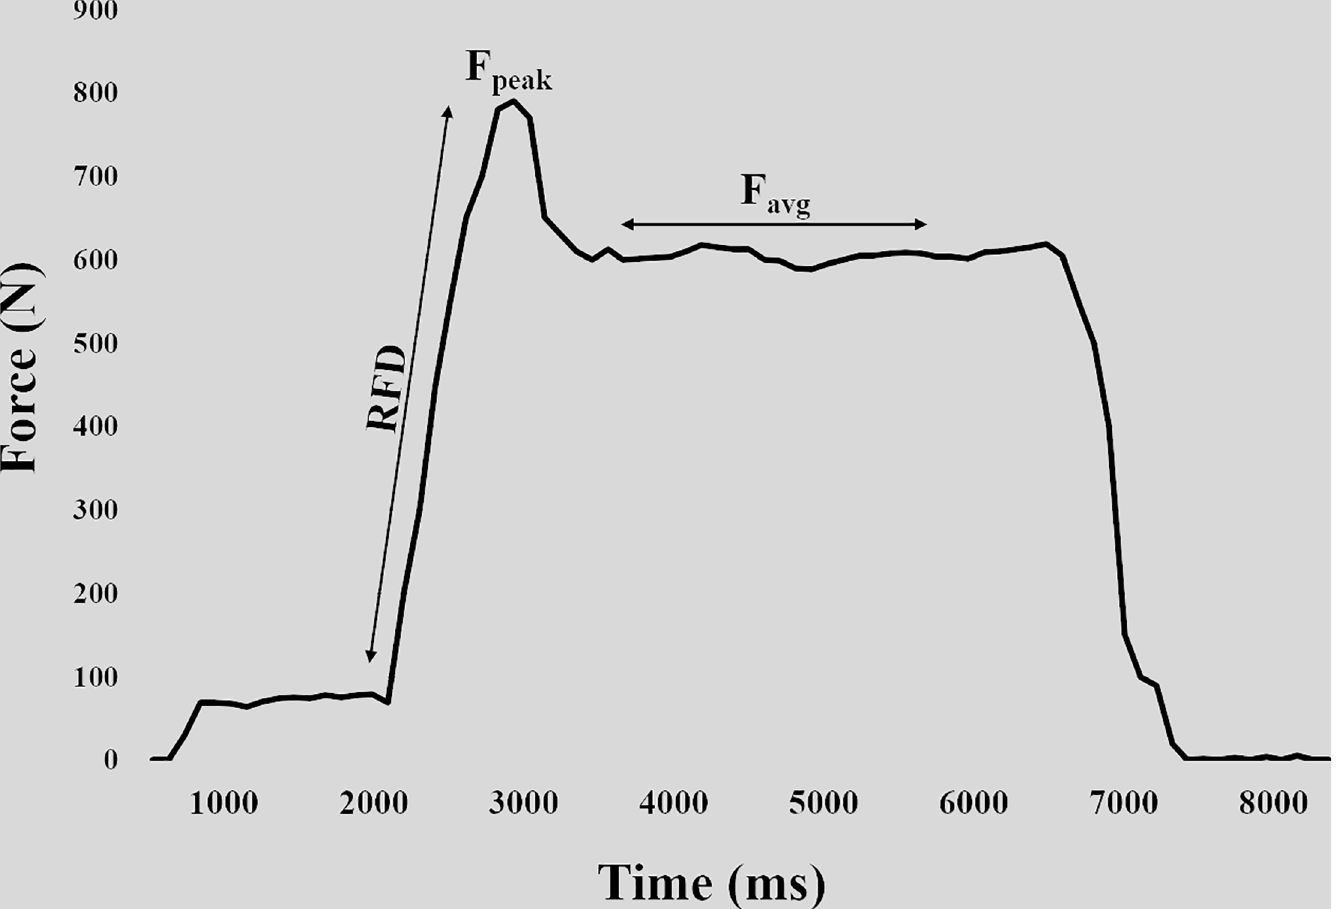
Fig 2. Schematic force curve produced in the isometric pull-up. Markers indicate rate of force development (RFD avg ), peak force (F peak ) and average force (F avg ).